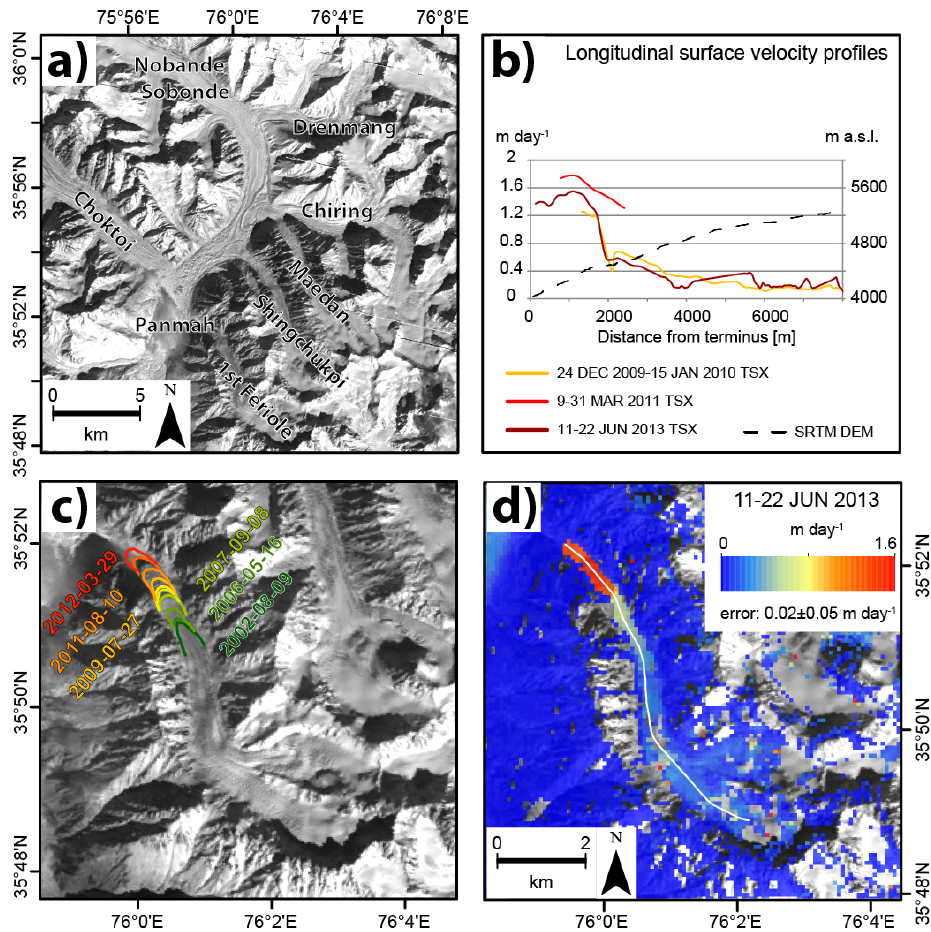
Figure 7. Termini advances and surface velocities for the first Feriole Glacier, Panmah Basin (a) . Panel (b) comprises the centerline velocity profiles and their changes over time (location of the profiles is marked in (d) ). Panel (c) shows the changing terminus positions since 2002. A surface velocity map derived from repeat TerraSAR-X SM imagery between 11 and 22 June 2013 is given in (d) . Background: Landsat TM, 15 January 2011, ( © USGS,